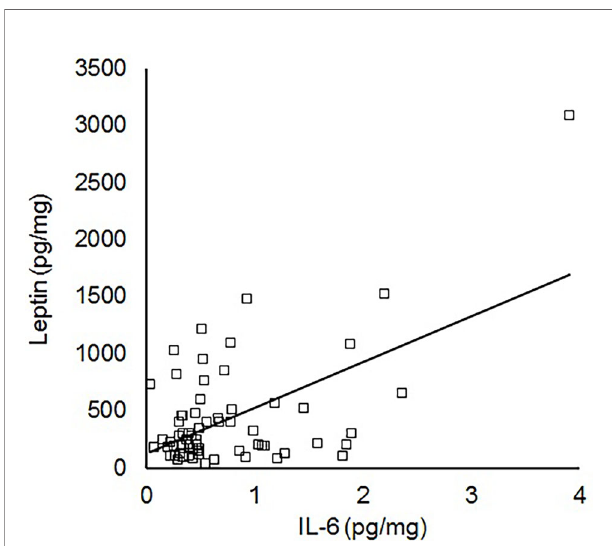
FIGURE 1 | Linear correlation between IL-6 and leptin within the cord blood of appropriate for gestational age term infants without sepsis (N=67, R=0.56,